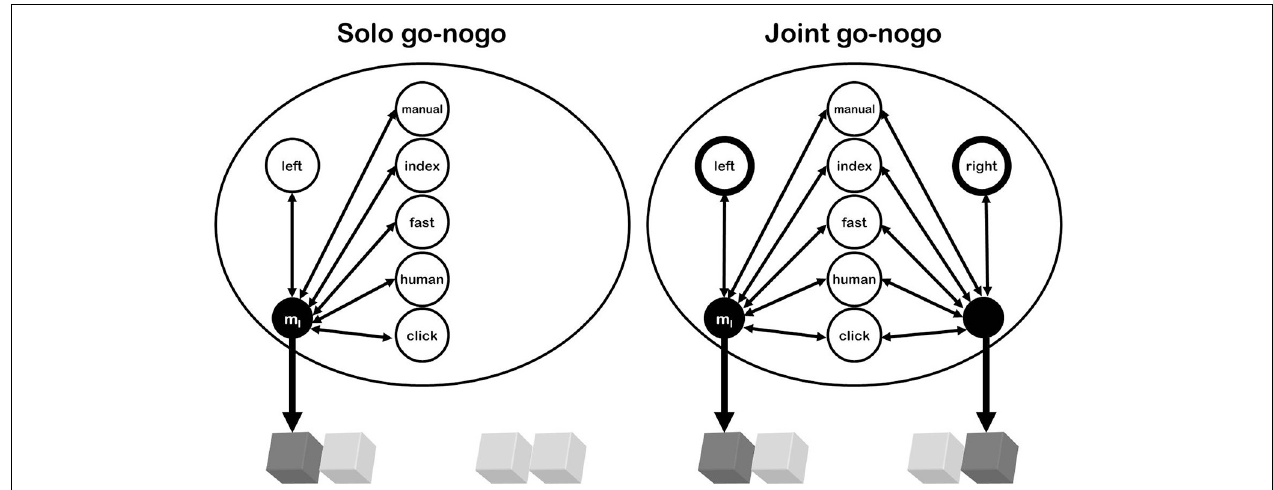
FIGURE 1 | Referential coding in the go-nogo versions of the Simon task. The figure shows tasks in which the agent operates the left response key. In the Solo version, a left keypress produces numerous action effects (i.e., something manual and fast, with an index finger moving, something human on the left that comes with a clicking sound, etc.) and can thus be coded in many ways; i.e., be represented by any of these and other action effects. In the Joint condition, the same action effects are produced and could be used